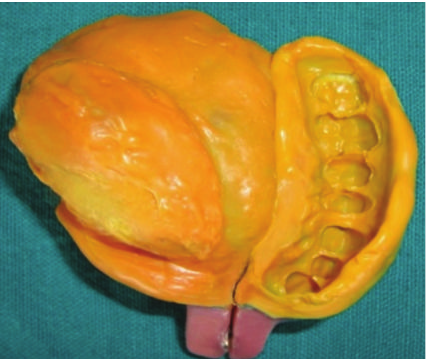
Figure 13: Assembled